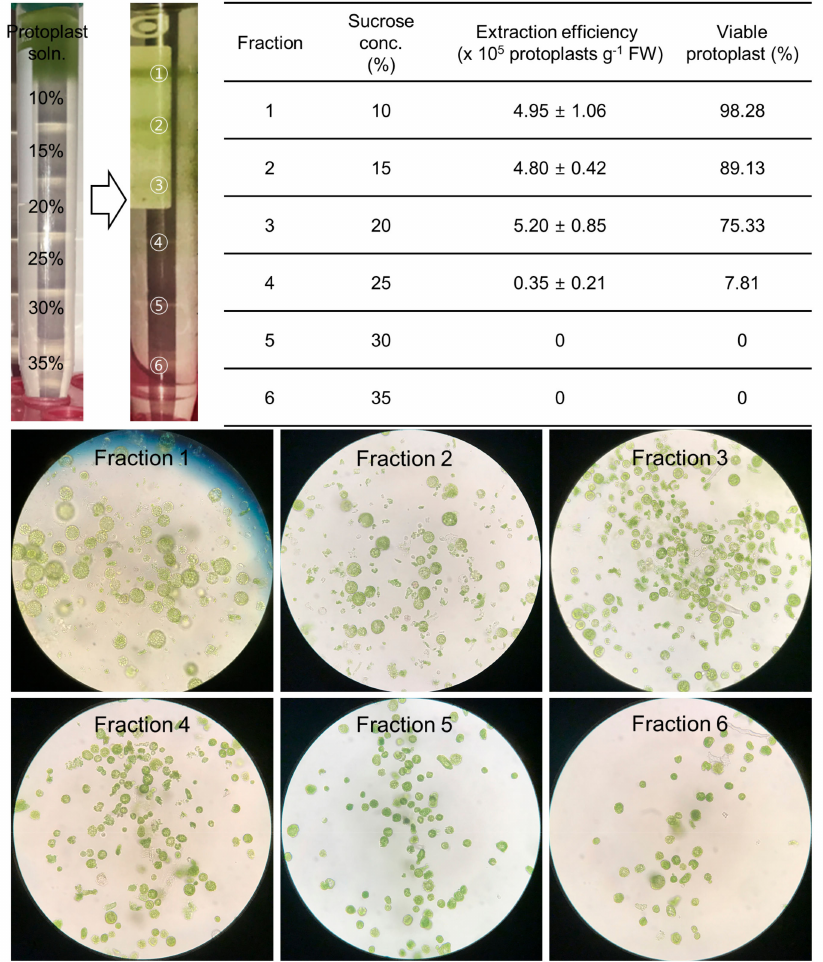
Figure 3. Comparison of protoplast extraction efficiencies by a sucrose gradient experiment involving 10–35% sucrose concentrations. Two milliliters of each solution of 10%, 15%, 20%, 25%, 30%, and 35% sucrose were sequentially added to a sterile 15 mL centrifuge tube, and then 2 mL of protoplast solution was slowly added on top. After they were centrifuged at 50 × g for 15 min, the protoplasts were harvested from the bands formed in each layer and observed under a microscope. (320 ×